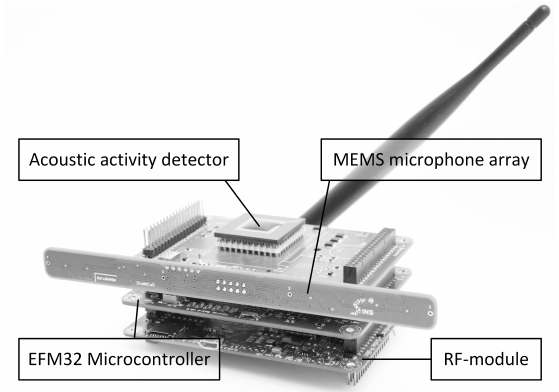
Figure 3. Picture of the